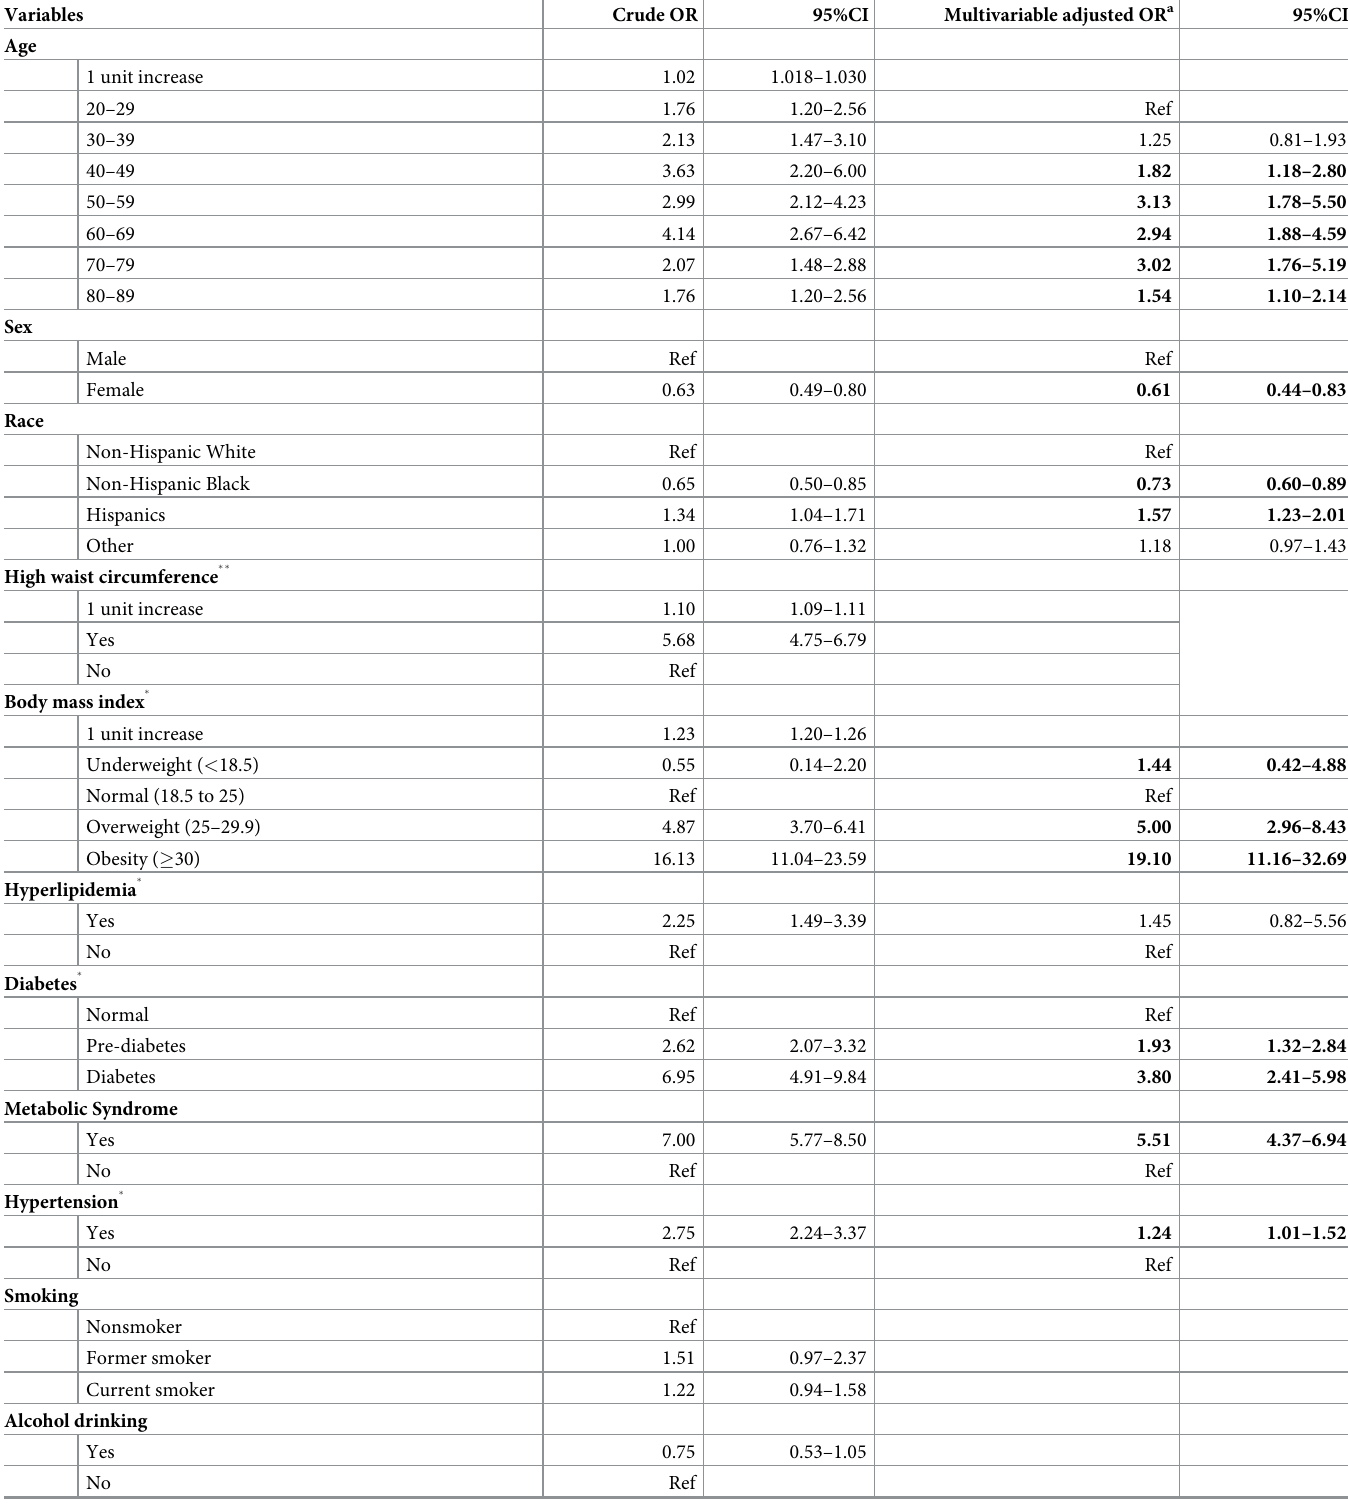
Table 4. Multivariable analysis for factors associated with NAFLD by